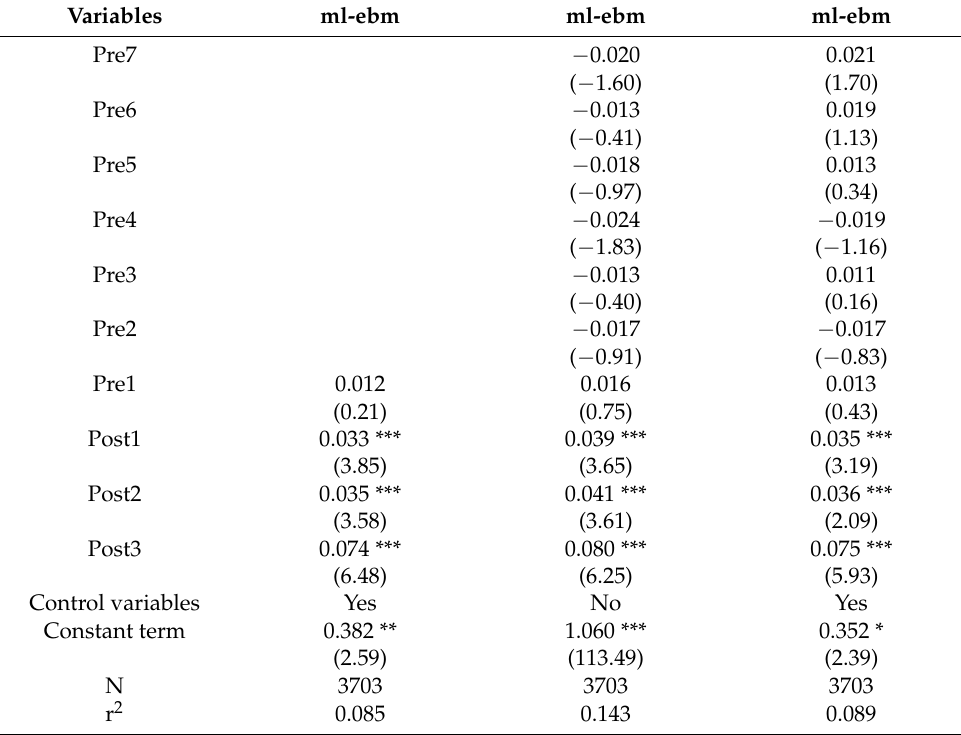
Table 4. Parallel trends and dynamic